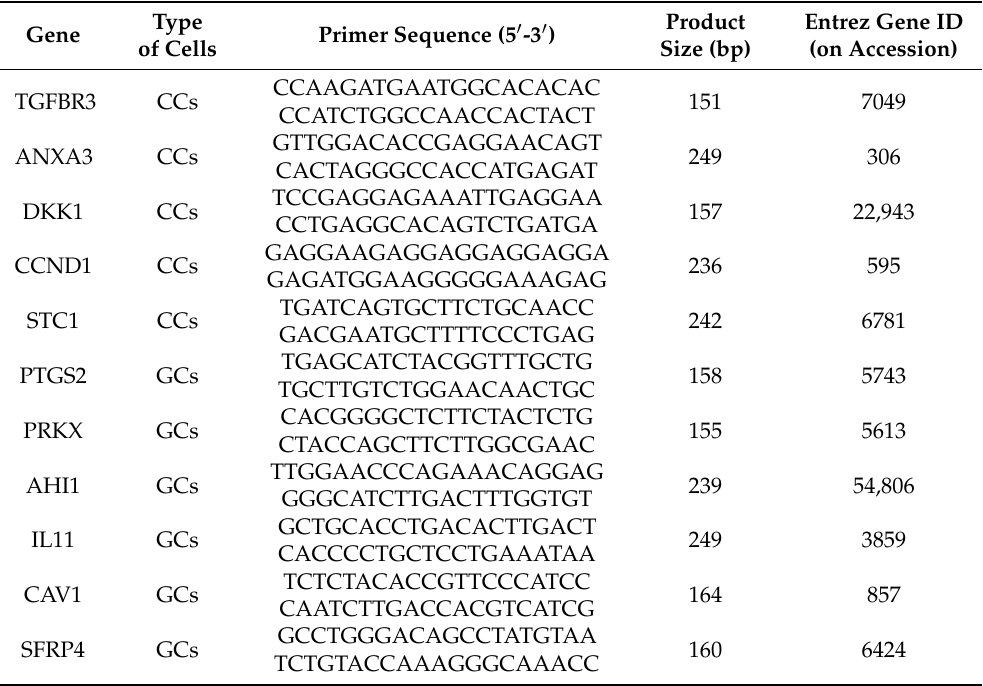
Table 1. Oligonucleotide sequences of primers used for RT − qPCR analysis. Type Gene of